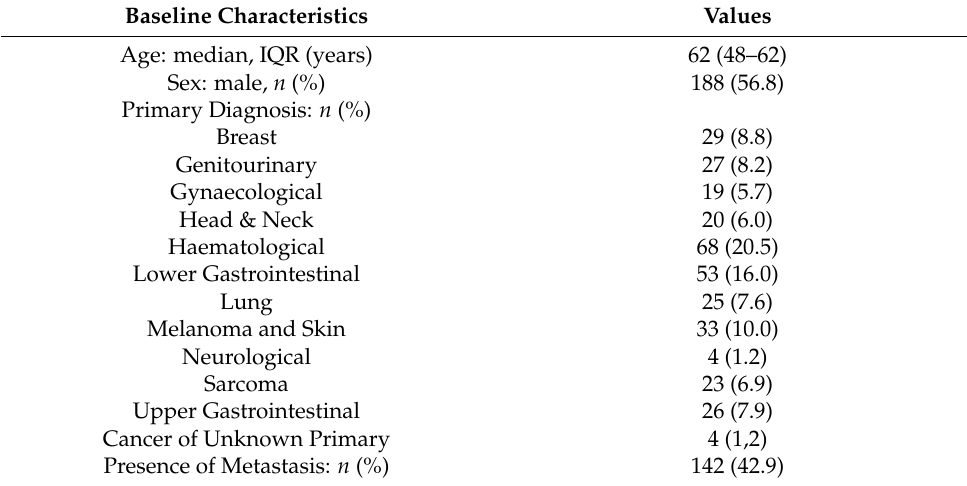
Table 1. Population characteristics.